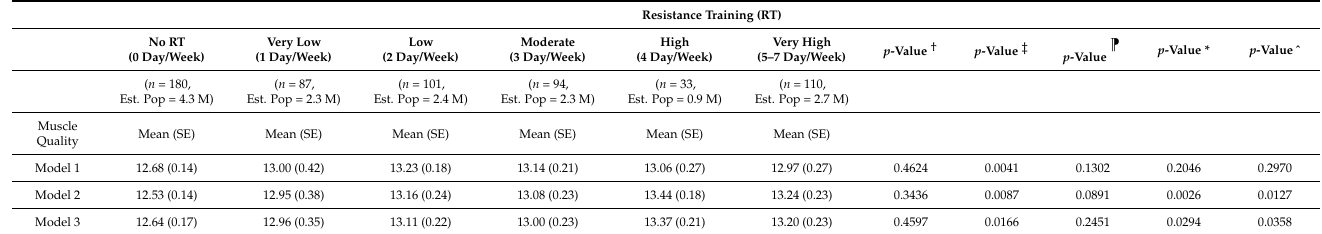
† p -value was from t -test: Comparison of muscle quality between no RT and very low RT. ‡ p -value was from t -test: Comparison of muscle quality between no RT and low to moderate RT. ⁋ p -value was from t -test: Comparison of muscle quality between no RT and moderate RT. * p -value was from t -test: Comparison of muscle quality between no RT and high RT. ^ p -value was from t-test: Com- parison of muscle quality between no RT and very high RT. Model 1 was unadjusted. Model 2 was adjusted with sex and race/ethnicity. Model 3 (=full model) was adjusted with sex, race/ethnicity, and arm fat Table 6. Association between resistance training (0 day/week, 1 day/week, 2 day/week, 3 day/week,